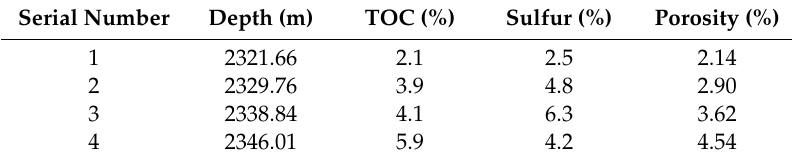
Table 1. Petrophysical properties of the shale particle samples.